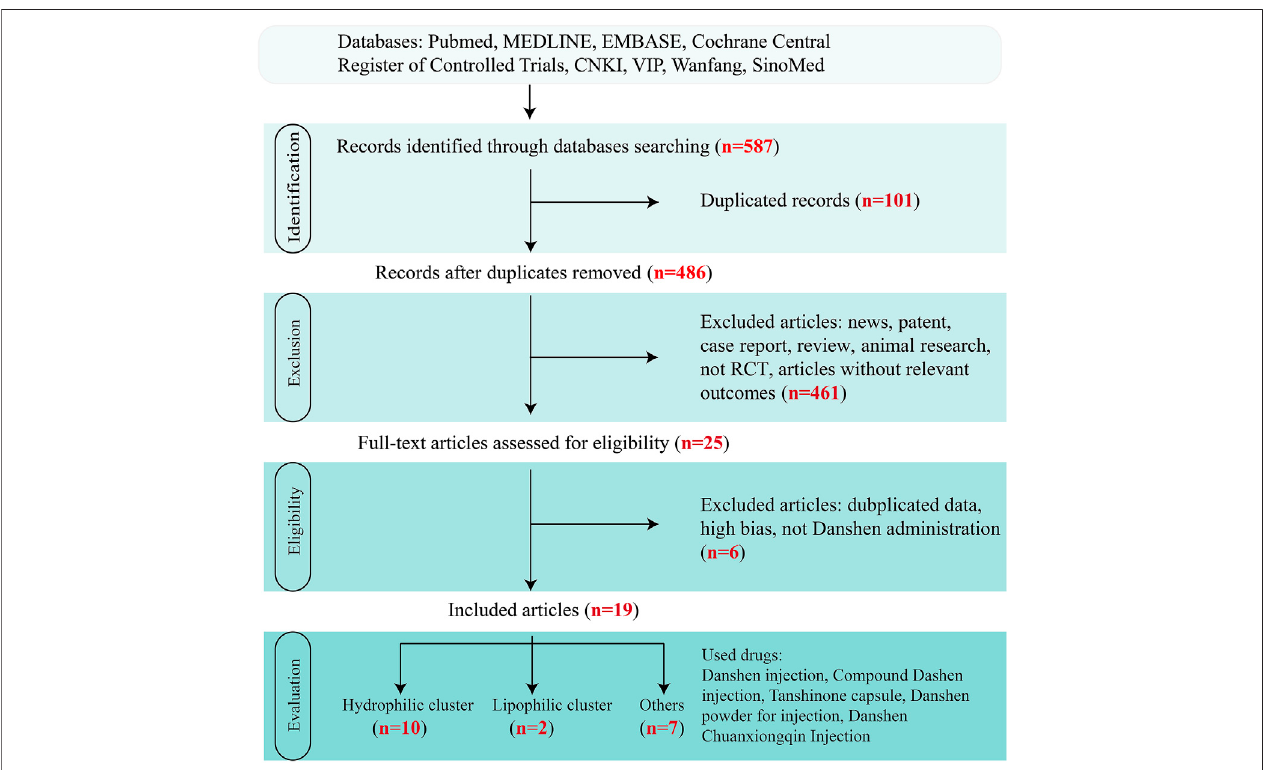
FIGURE 3 | Flow diagram of study selection of clinical trials. Clinial records on Danshen products for in fl ammatory bowel disease (IBD) were screened through the steps of identi fi cation, exclusion, eligibility, and evaluation.